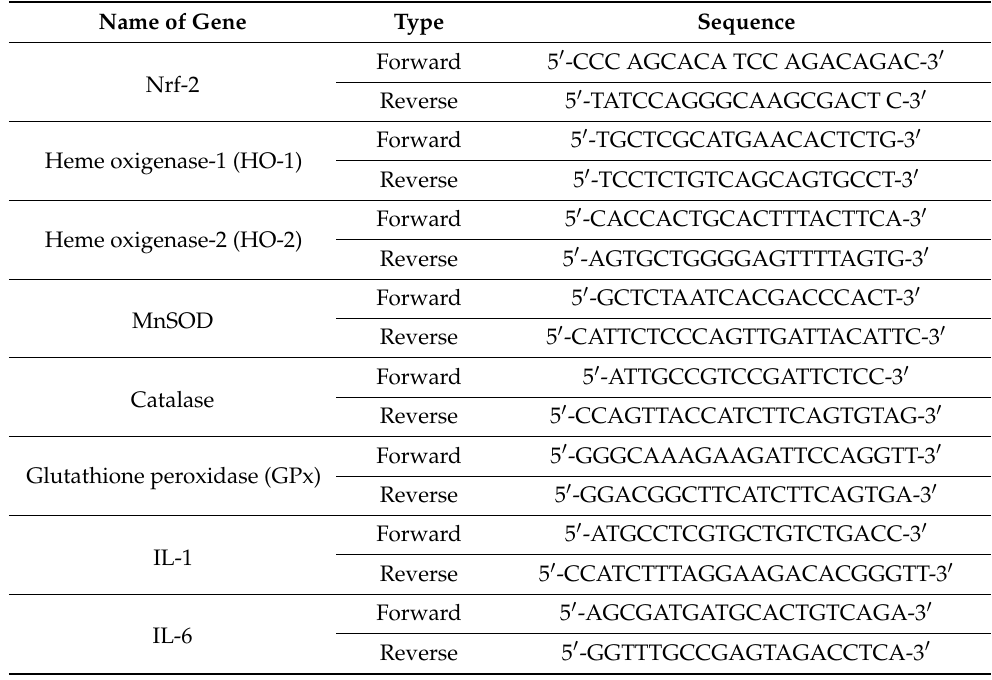
Table 1. The forward and reverse sequence of the primer applied in this experiment. Name of Gene